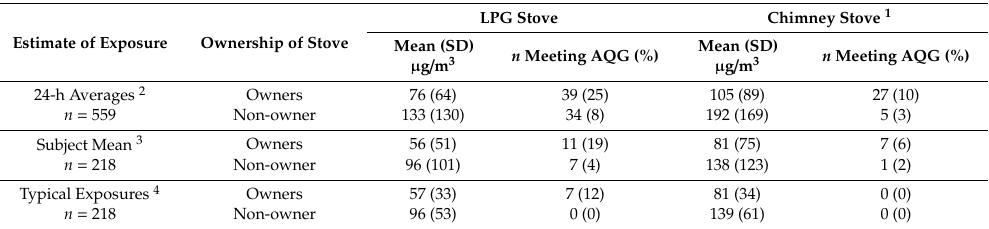
Figure 2. Distributions of alternative estimates of subject-specific exposure separated by LPG stove ownership ( A–C ) and chimney stove ownership, excluding LPG stove owners ( D–F ). Alternative estimates are single 24-h averages ( A , D ), subject means of 2–3 repeated 24-h measures ( B , E ), and subject mean using best linear unbiased predictor from the mixed model ( C , F ). Table 4. Comparison of alternatives estimates of subject-specific pregnancy exposures by LPG stove ownership and chimney stove ownership.